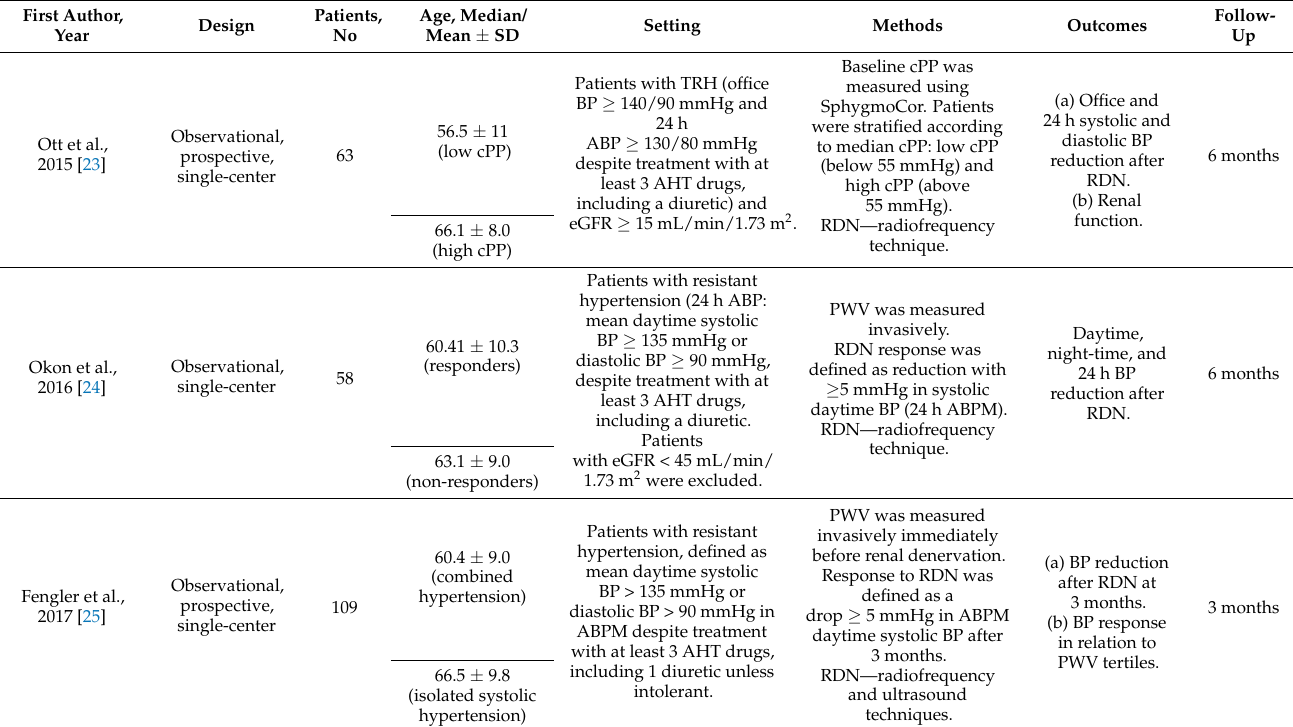
Table 1. General characteristics of studies included in the present systematic review.